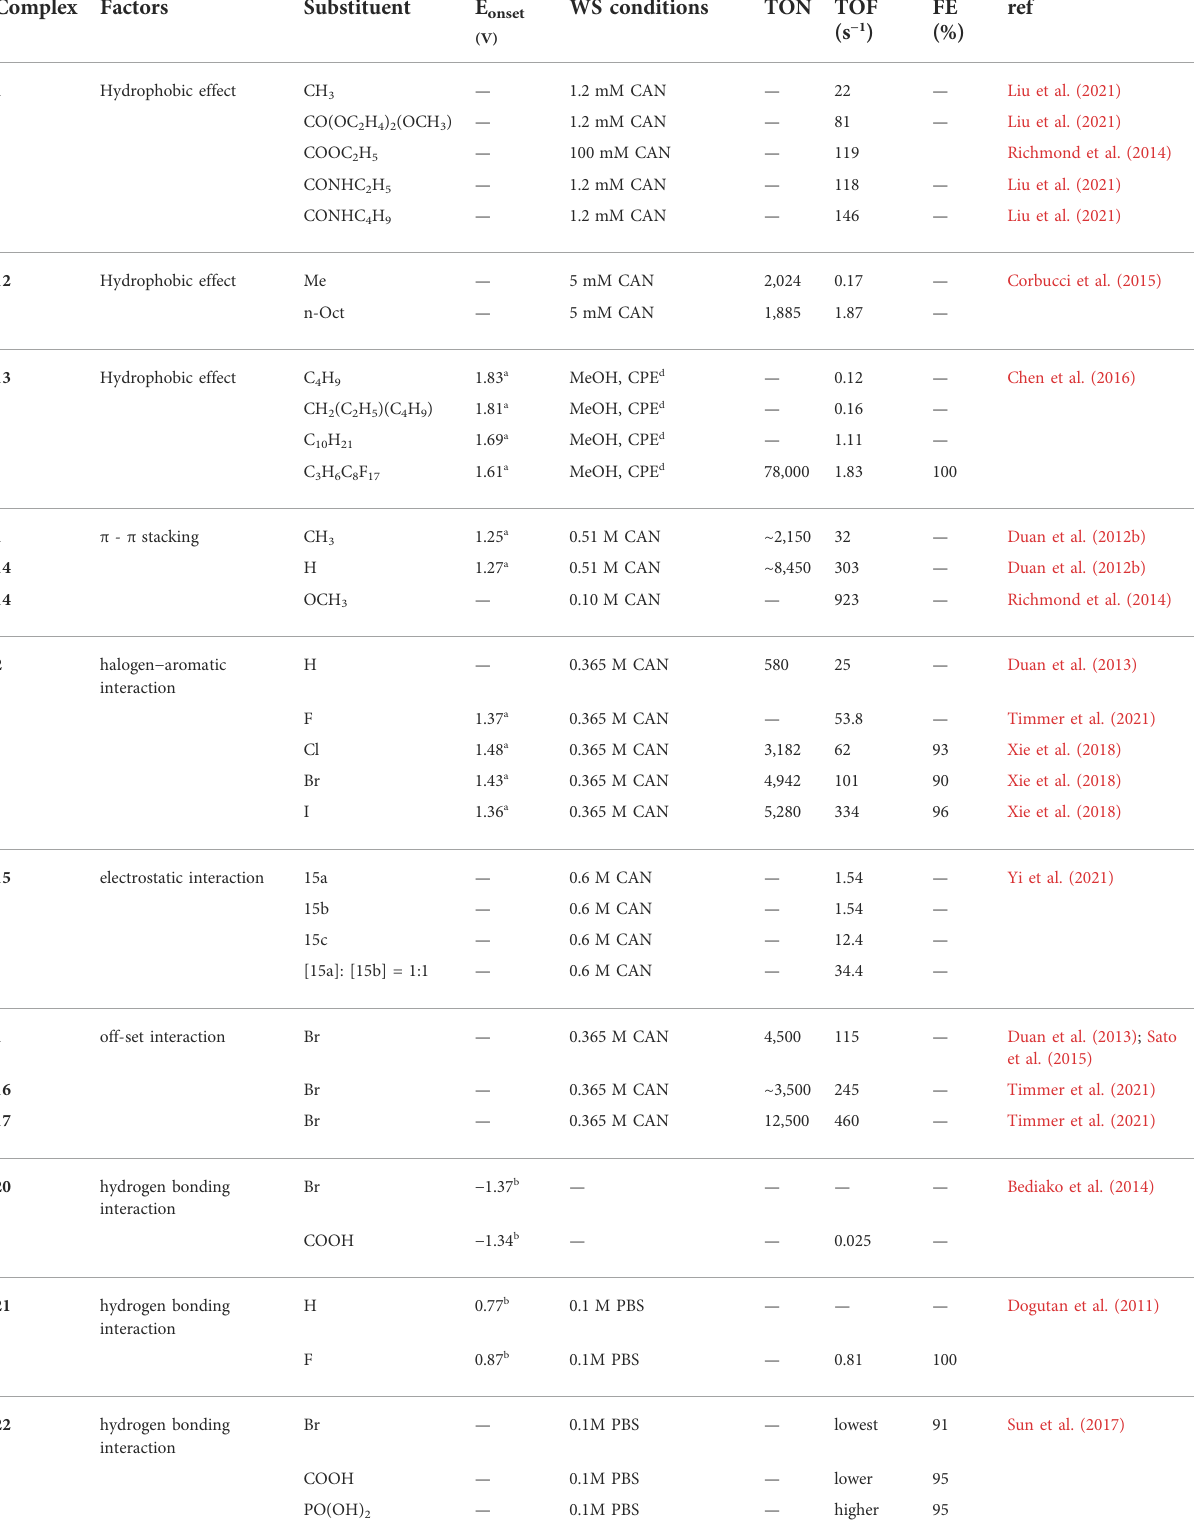
TABLE 2 Properties of metal complexes with different intermolecular interactions. Complex